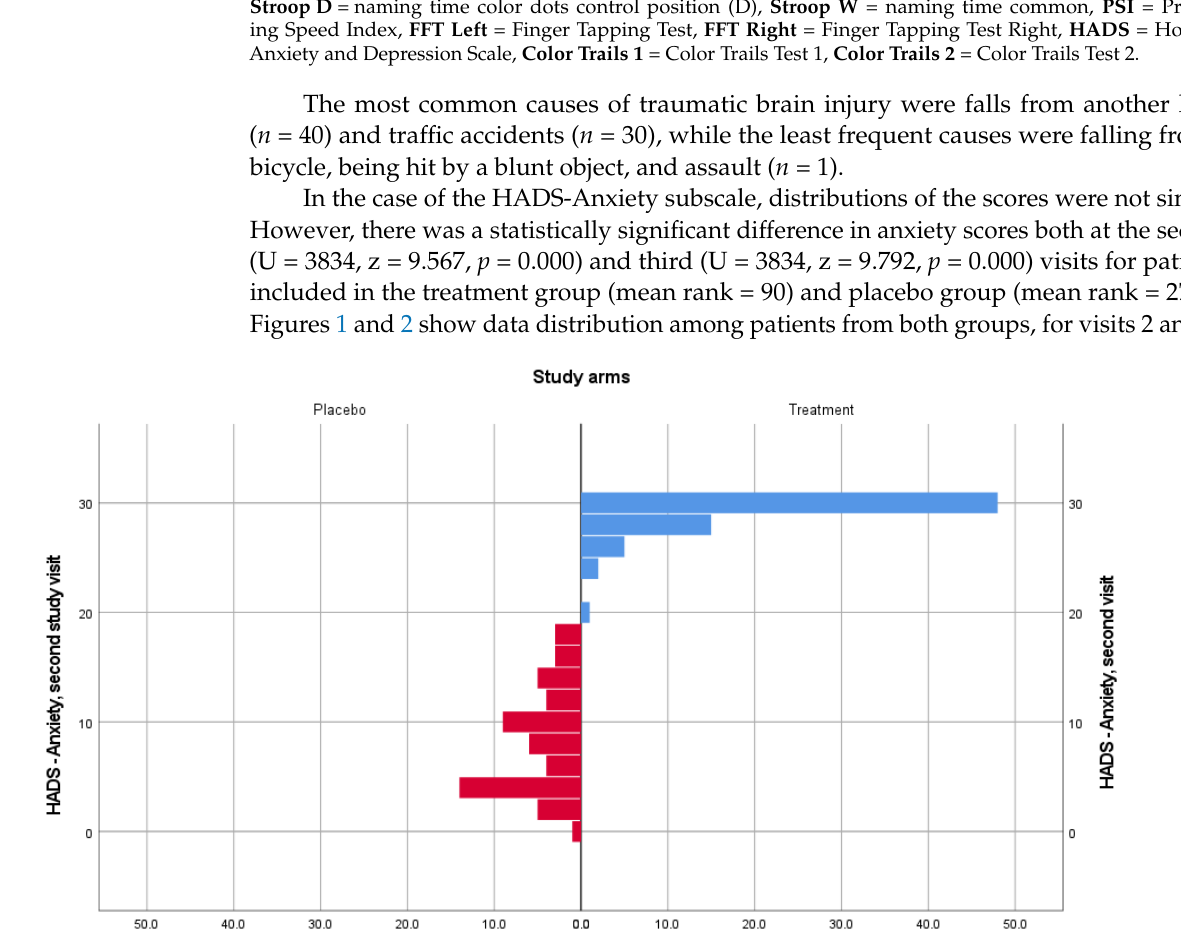
Figure 2. HADS-Anxiety score distribution for the treatment and placebo groups for the third visit. For the HADS depression subscale, the distributions of scores were similar. Median depression scores for patients from the treatment group (median visit 2, visit 3 = 7) and placebo group (median visit 2 = 7, median visit 3 = 8) were not statistically significant different at the second (U = 1906.5, z = −0 .053, p = 0.958) and third (U = 1547, z = − 1.850, p = 0.065) study visits. Figures 3 and 4 show data distribution among patients from both treatment groups, for visits 2 and 3. Based on computed effect size, Cerebrolysin has a large effect size on anxiety at both visits (0.73) and a small effect on depression at visit 3 (0.023).